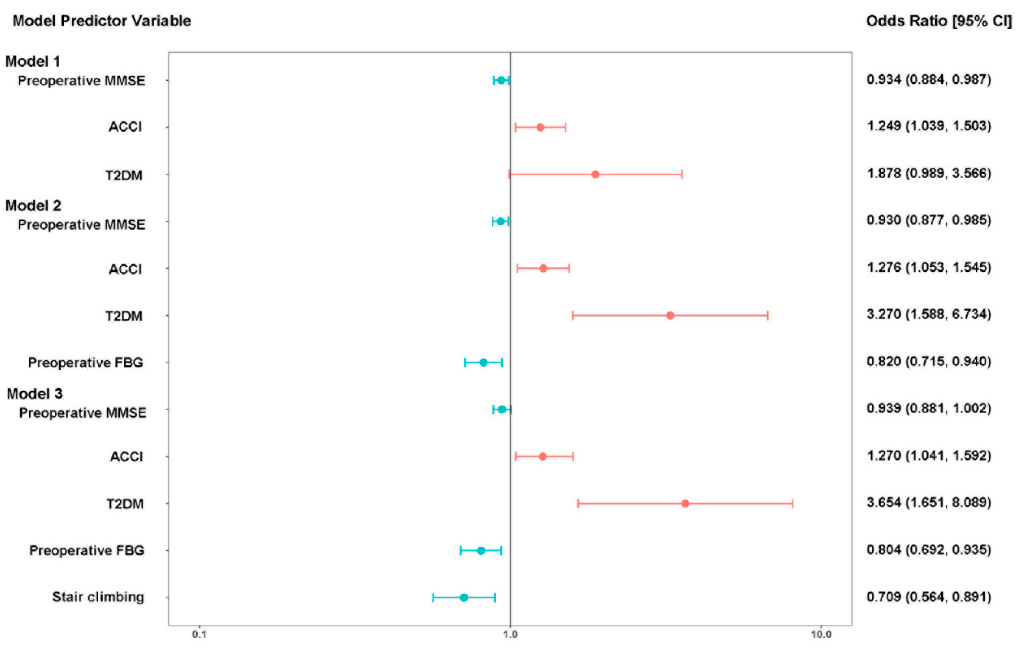
Figure 2. Predictors of POD with OR and 95% CI. MMSE: Mini-Mental State Exam; ACCI: age-adjusted Charlson comorbidity index; T2DM: type 2 diabetes mellitus; FBG, fasting blood glucose.